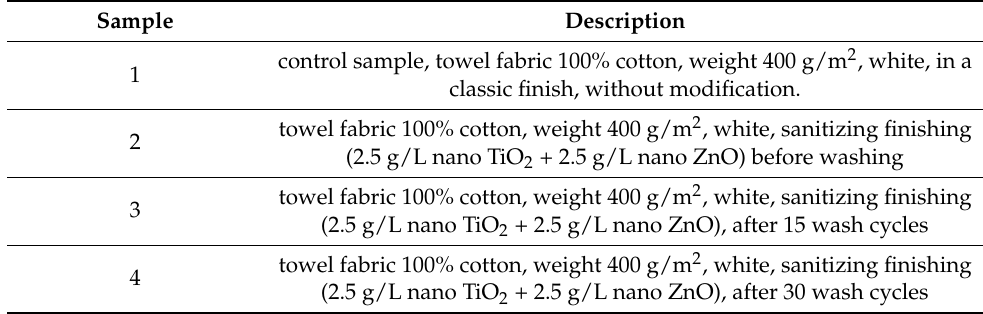
Table 4. Characteristics of the tested cotton towels.